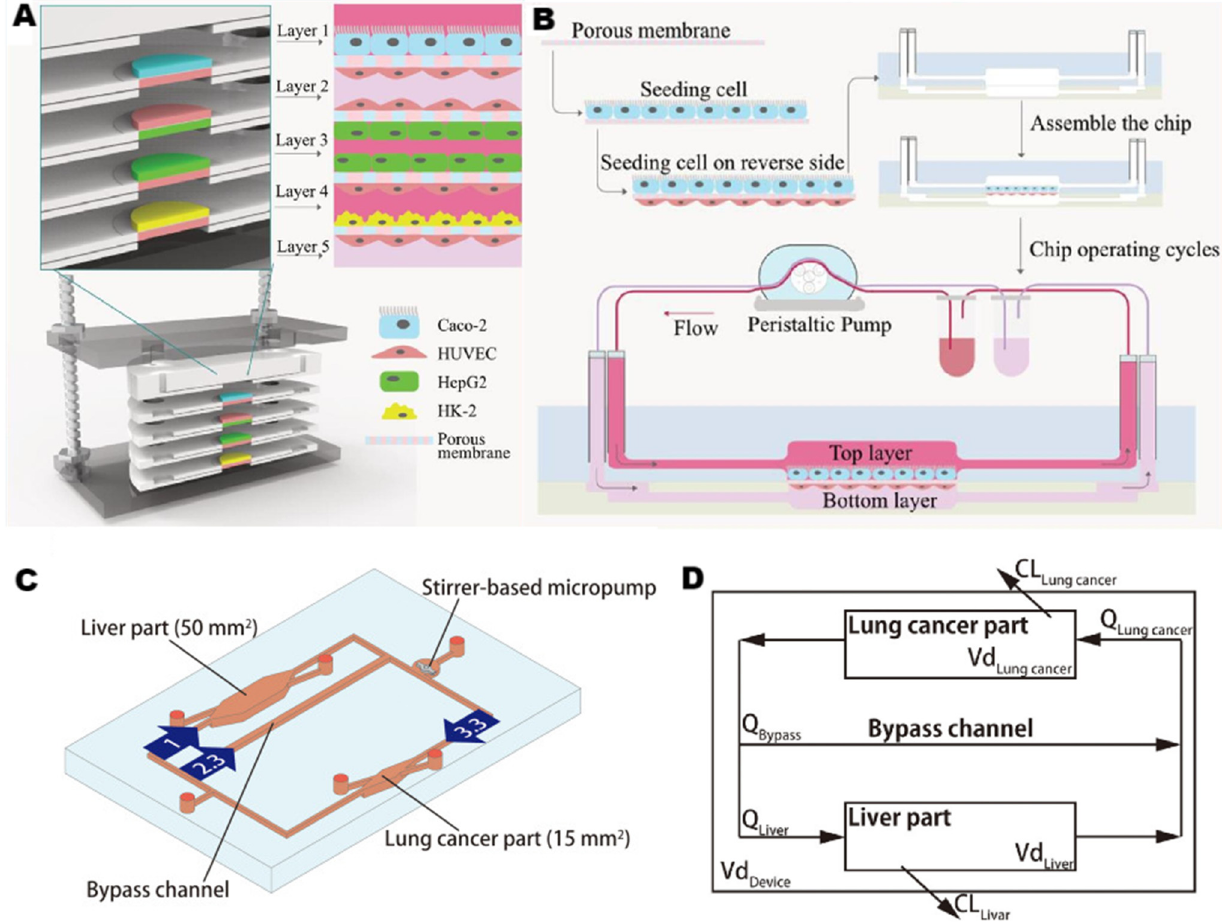
Figure 4. Example of multi-organ chips platforms. ( A ) Multi-organ chips based on liver, intestinal, vascular, and kidney chips. Caco-2, HUVEC, HepG2, and HK-2 occupy one floor from top to bottom ( B ) Taking a two-layer chip assembly as an example, the system was built in the order of inoculating cells to a porous membrane, providing a cell culture medium and assembling chips. The peristaltic pump provides power for fluid. ( C ) The liver and lung cancer parts on chips are connected through a microchannel. Channel is also equipped with a stirrer-based micropump to provide power. The value in the arrow is the flow ratio. ( D ) Concept diagram of PK model based on the multi-organ chip. ( A , B ), reproduced with permission of [23], Copyright © 2020. Published by Elsevier. ( C , D ) reproduced with permission of [91], Copyright © 2020. Published by AIP Publishing.